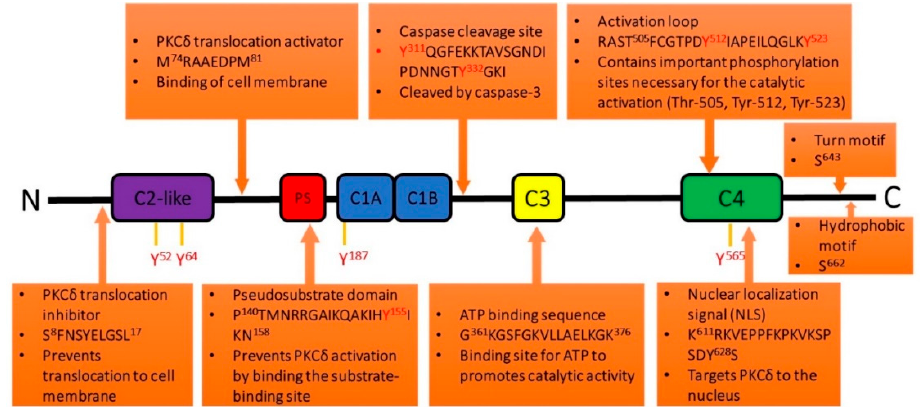
Figure 3. Important amino acid sequences (activators, inhibitors, regulatory signals) and tyrosine phosphorylation sites on PKC δ . Adapted from Malavez et al., 2009 [27]. Two important tyrosine phosphorylation sites are PKC δ Tyr-155 and PKC δ Tyr-311, which are critical phosphorylation sites associated with PKC δ -mediated proinflammatory signaling and the initiation of cytotoxic/apoptotic pathways [54–56]. Phosphorylation of PKC δ at Tyr-155 and Tyr-311 is required for nuclear translocation and enzyme cleavage [24,54,55]. Tyr-155 is located between the regulatory domain pseudo-substrate motif and the C1A domain and regulates apoptosis and gene expression [29,30,57]. PKC δ phosphorylation at Tyr-311, located in the hinge region, causes a PKC δ Tyr-155 and PKC δ Tyr-311 are phosphorylated during sepsis and play key roles in sepsis-induced cell interactions (See Sections 2.2.3 and 2.2.4) [21,24]. Tyr-155 phosphorylation is also significant